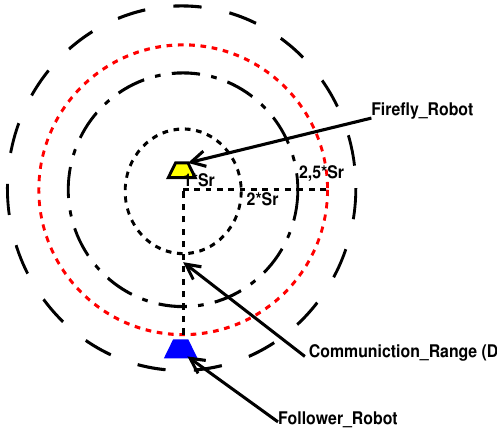
Figure 1. Defined ranges for sensing (range in which the robot can directly localize targets and obstacles, where 1 × S r is the sensing range and 2 × S r is twice the sensing range) and communication (distance to be kept between follow _ robot and Firefly _ robot